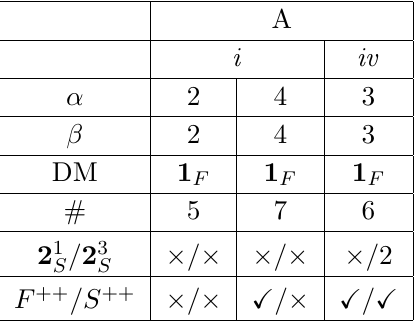
Table 6. The same as in table 2 for Class 1.e of (cid:12)gure 1.